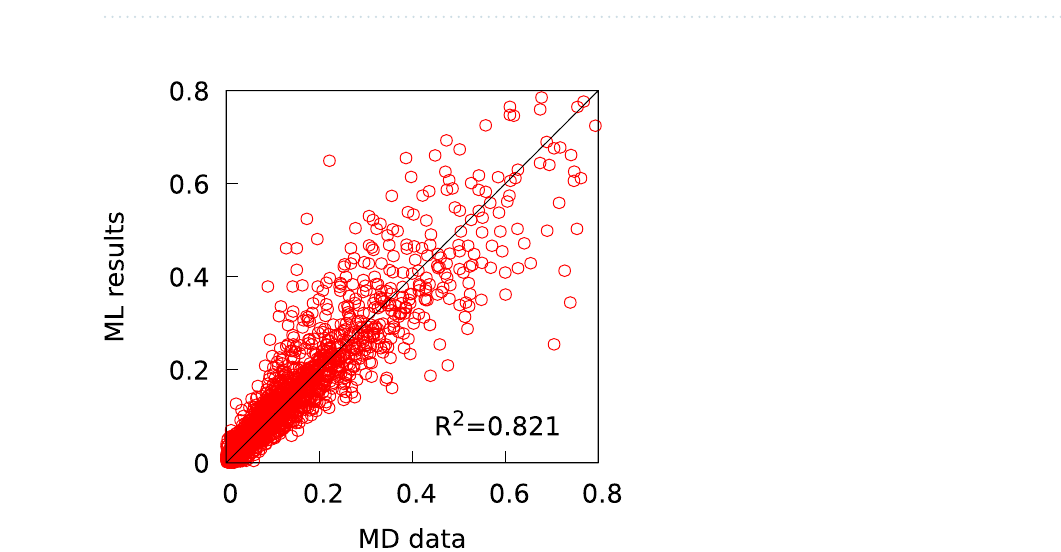
Table 3. Descriptors used in the ML process. Some variables fixed to specific values are not used because they do not affect the ML results.